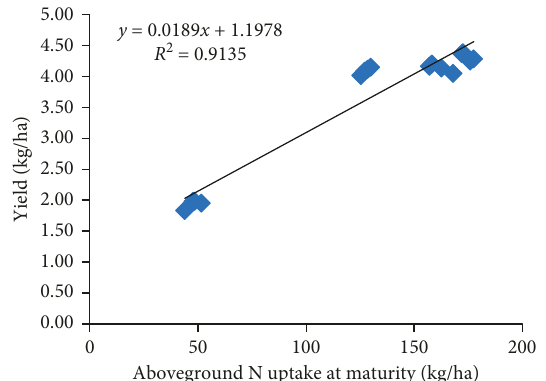
Figure 2: Relationship between the grain yields and total above- ground N at maturity across all treatments.